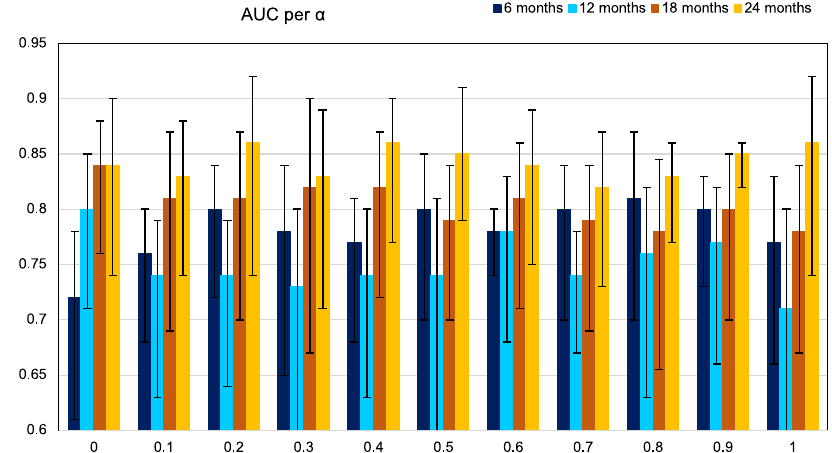
Fig. 2 Baseline gene expression pro fi ling is accurate at predicting long-term immunotherapy outcomes. Comparison of elastic net binomial models designed for the prediction of PFS at consecutive 6-month intervals across α values ranging from 0 to 1; α equals “ 0 ” for ridge and “ 1 ” for lasso regression. Models designed for the prediction of PFS at 24 months perform consistently better in comparison with models designed for the prediction of PFS at 6, 12, and 18 months. The error bars correspond to the 95% con fi dence intervals. PFS progression-free survival.